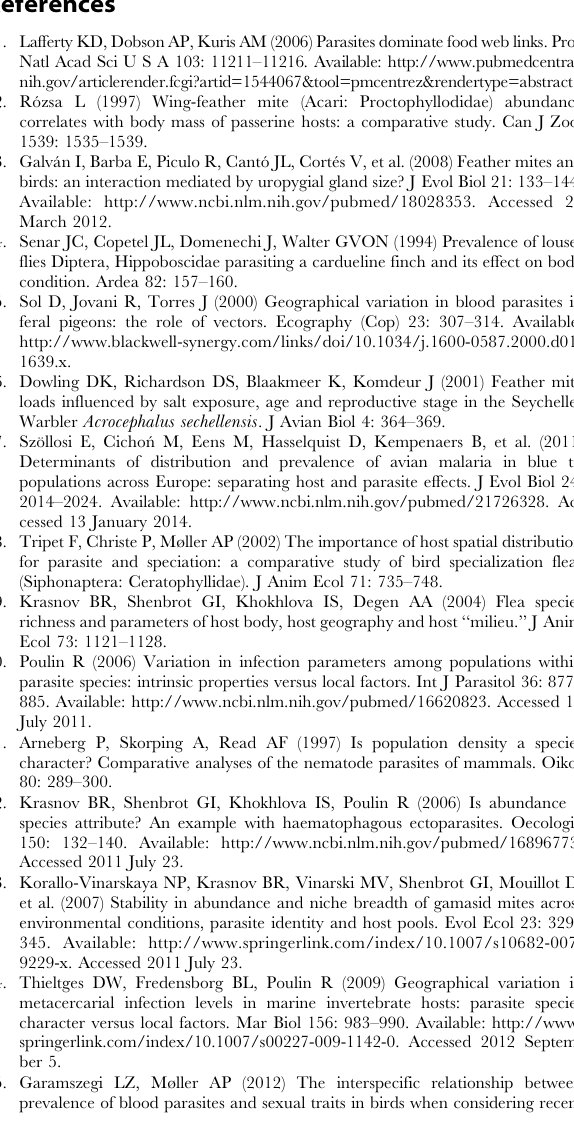
Table S1 Intensity of feather mites (Min= Minimum, Max = Maximum, Med= Median) and sample size (N) for each bird species and country. Table S2 Prevalence of feather mites (Prev = Preva- lence; i.e. proportion of birds with at least one